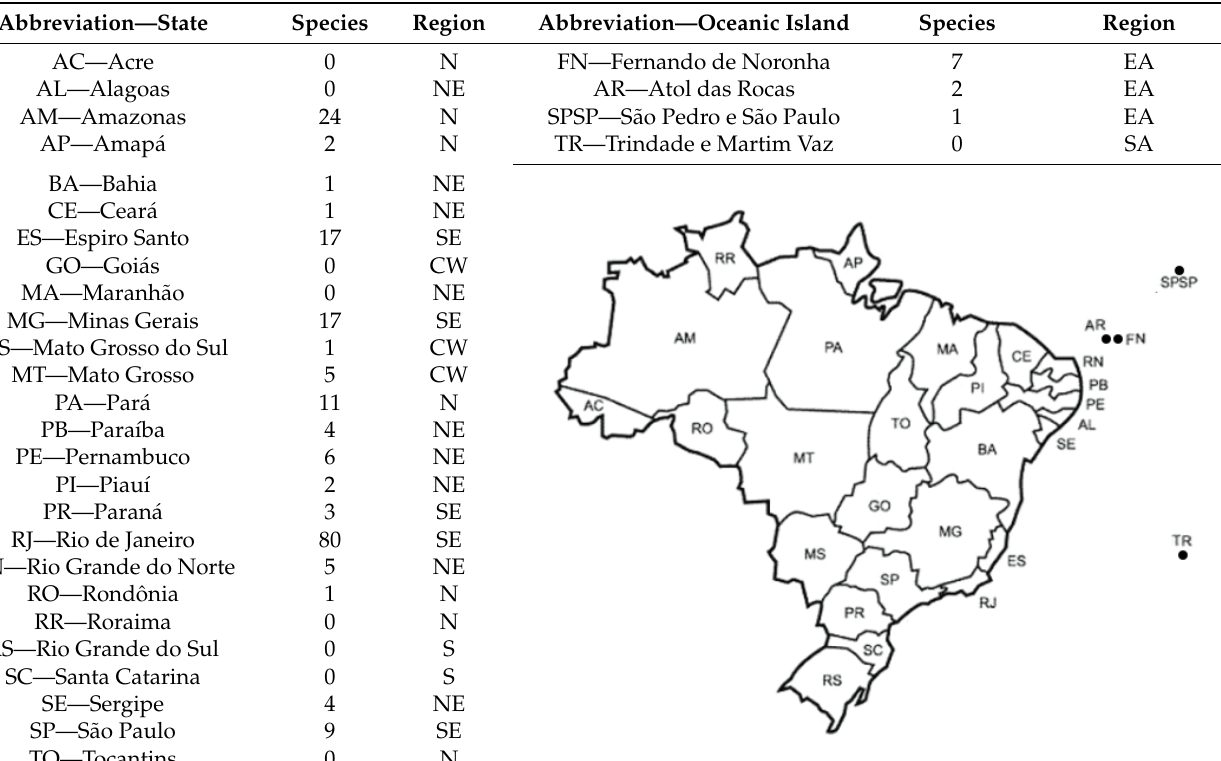
Table 1. Abbreviations of names of the Brazilian states and oceanic islands. Number of Poduromopha species recorded and region location of each state and oceanic island. Brazilian continental region designations: N––north, NE––northeast, CW––west (central part), SE––southeast, S––south. Brazilian insular region: EA––equatorial Atlantic; SA––South Atlantic. Map shows the geographic position of Brazilian states and oceanic islands.